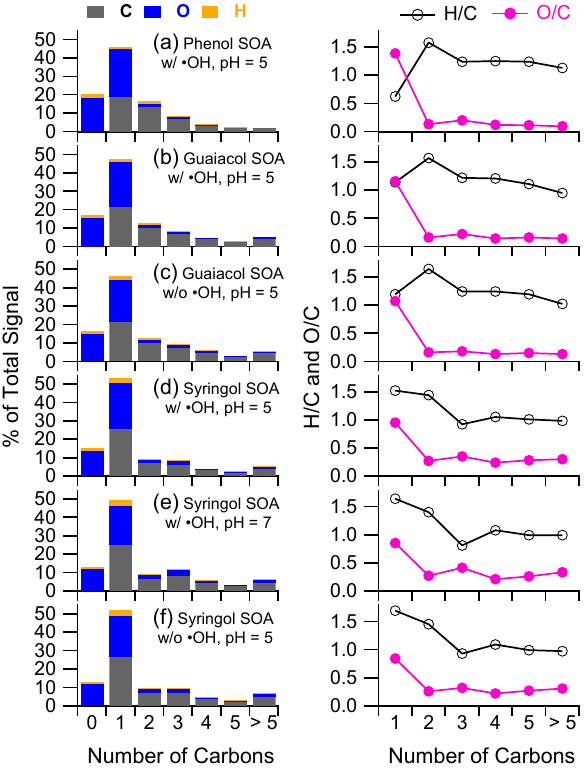
Fig. 3. Distribution of elements (C, O, and H) and elemental ratios (H/C and O/C) as a function of the number of carbons in each AMS fragment of the SOA products for (a) phenol, (b–c) guaiacol, (d–f) syringol. The experimental conditions are shown in the